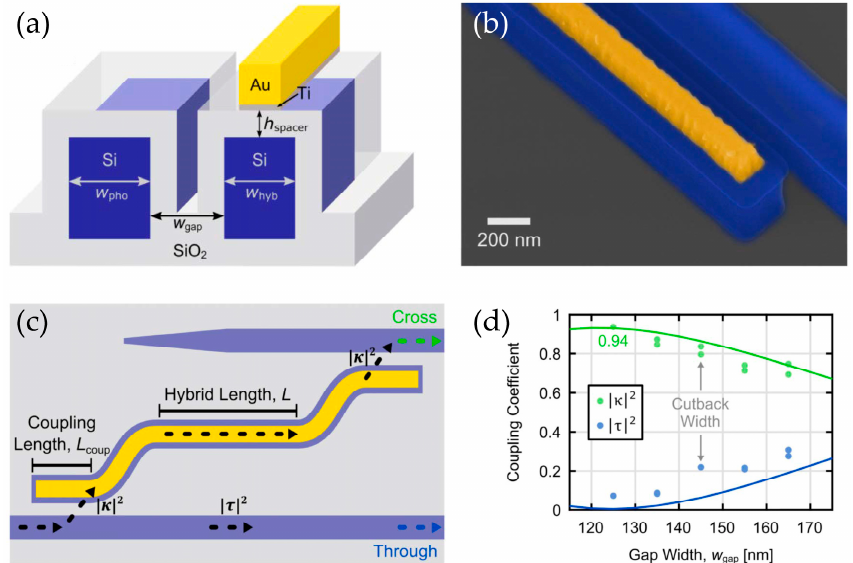
Figure 12. Directional coupling between silicon waveguides and hybrid plasmonic waveguides. ( a ) Schematic structure and ( b ) SEM image of the proposed coupler. ( c ) Schematic structure used to measure the coupling efficiency in the experiment. ( d ) Measured (dots) and simulated (solid lines) coupling efficiencies as functions of the gap width. Figures reproduced from [112].